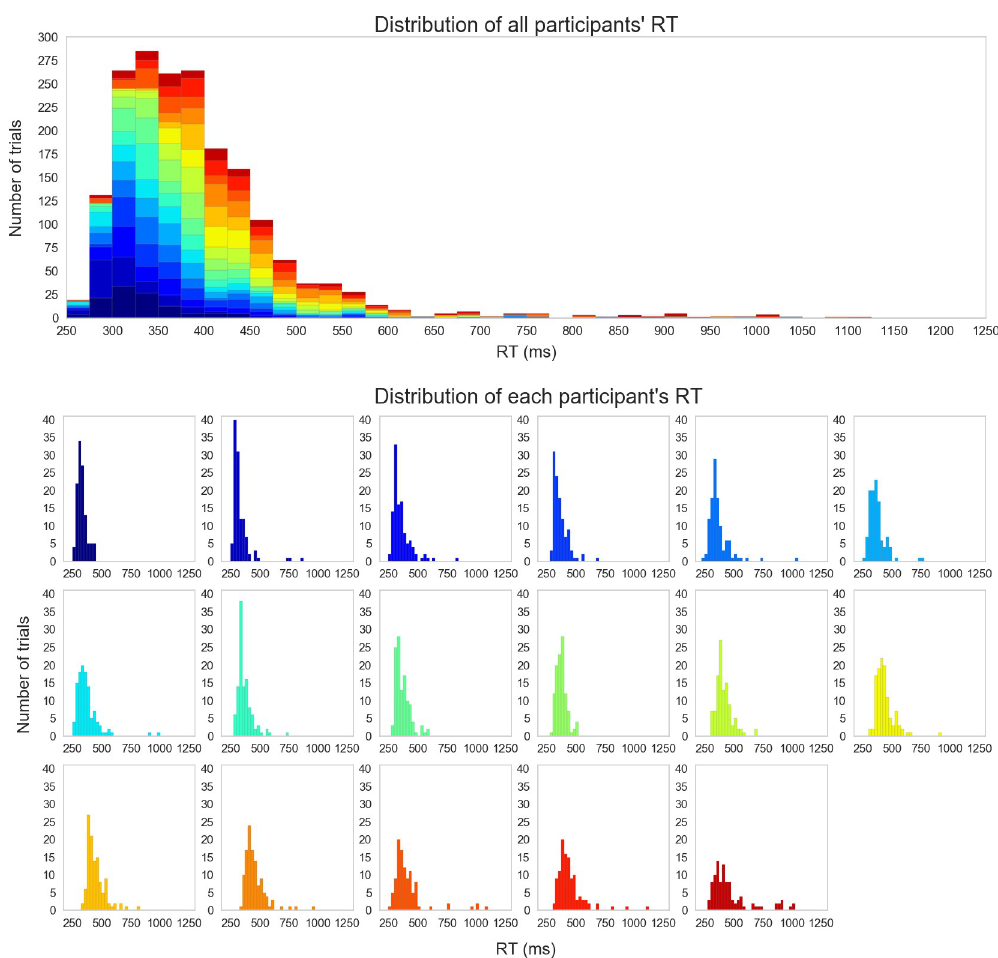
Fig 5. Distributions of RTs on all valid trials. The upper panel shows a histogram of the RT distributions of all participants. The lower panel shows RT distributions of individual participants, starting with the individual with the shortest mean RT. The different colors represent histograms of different individuals, which are common to the upper and lower figures. Note that two trials (4,988 ms and 1,662 ms, respectively) were not shown for visual purposes.